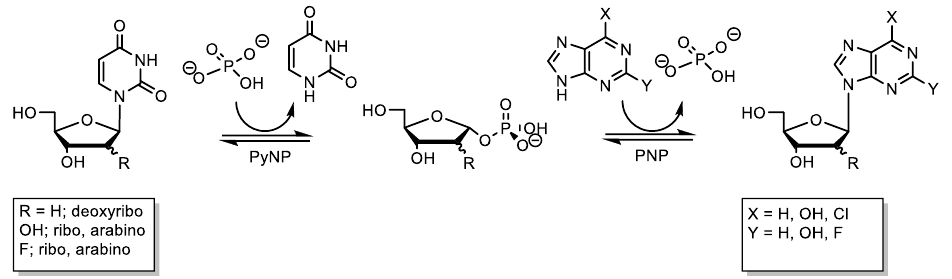
Figure 1. Enzymatic synthesis of modified nucleosides by nucleoside phosphorylase-catalyzed transglycosylation. For the synthesis of purine nucleosides, it is advantageous to use pyrimidine nucleosides as donors, as they are cheaply available and thermodynamically enhance purine nucleoside synthesis. In this bi-enzymatic reaction, the PyNP is needed to cleave the donor nucleoside and the PNP catalyzes the target nucleoside synthesis.